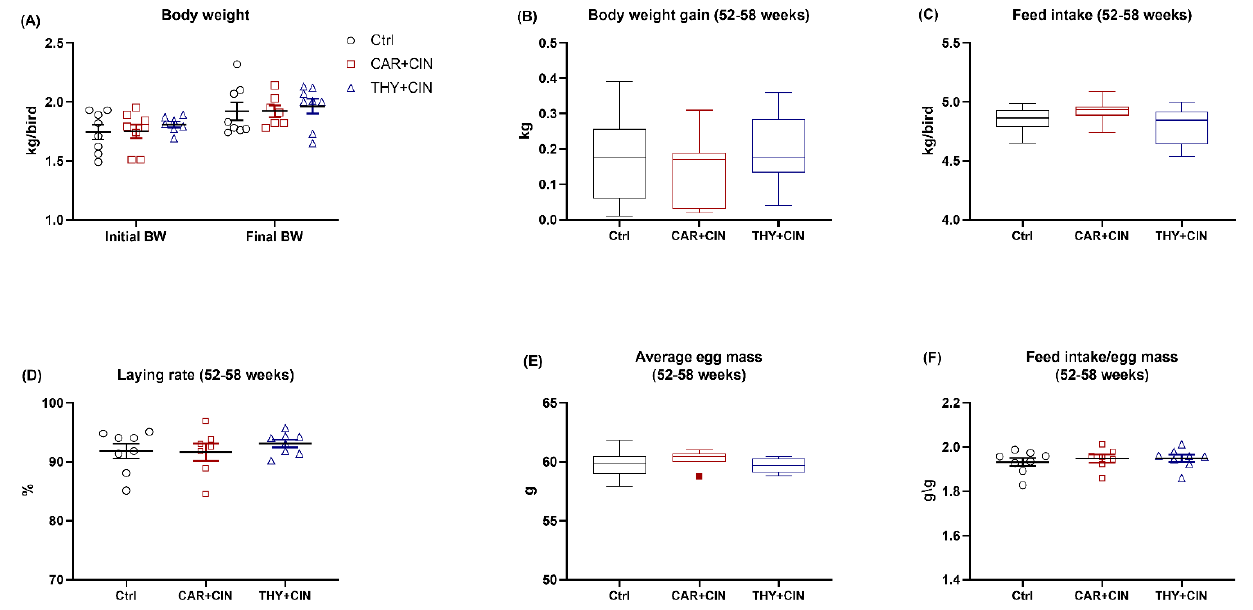
Figure 1. Impacts of the combination of cinnamaldehyde with carvacrol (CAR+CIN) or thymol (THY+CIN) on ( A ) body weight (BW) at week 52 (initial BW) and week 58 (final BW), as well as ( B ) body weight gain, ( C ) feed intake, ( D ) laying rate, ( E ) average egg mass, and ( F ) feed intake/egg mass of laying hens from 52 to 58 weeks. Values are mean ± standard error (SE) represented by vertical bars in a scatter plot. In the box-whiskers plots, boxes are bounded by the 25th and 75th percentiles, with the median shown by the line bisecting the box. Whiskers extend to the full range of the data. Outliers are represented by dots. Statistical significance was identified at p < 0.05 ( n = 8).